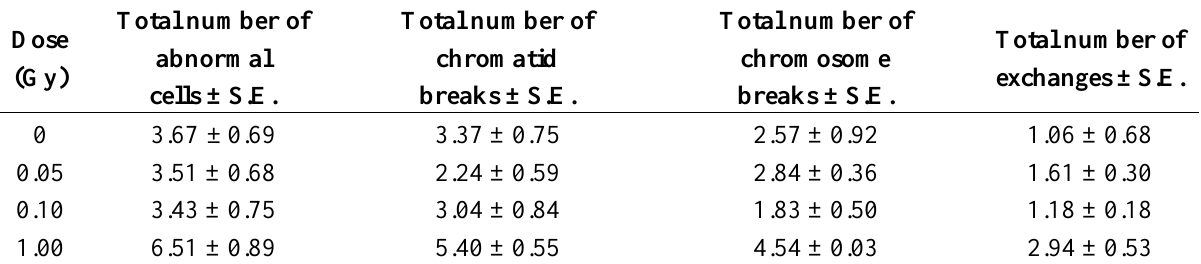
Table 7. Average square root transformation values [  X +  (X+1)] of mean aberrations in 100 cells scored ± standard error of the mean (S.E.) derived from the raw data of the frequencies of each type of aberration, including abnormal cells as shown in Table 5 (1 mo post- irradiation).